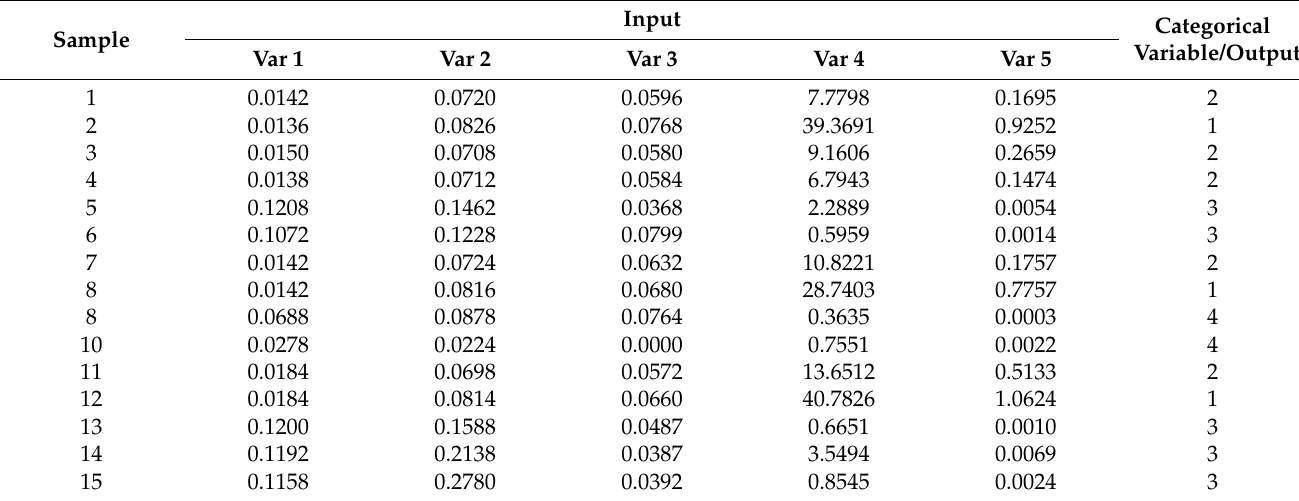
Table 5. Input and target output sampled used for decision tree.